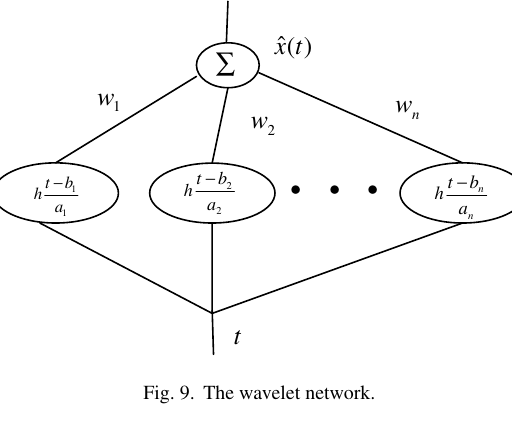
Fig. 9. The wavelet